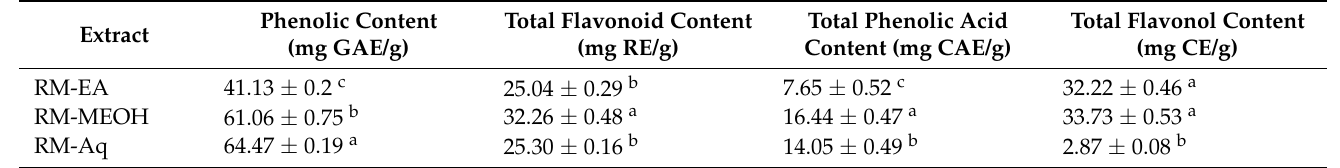
Table 1. Phytochemical composition.